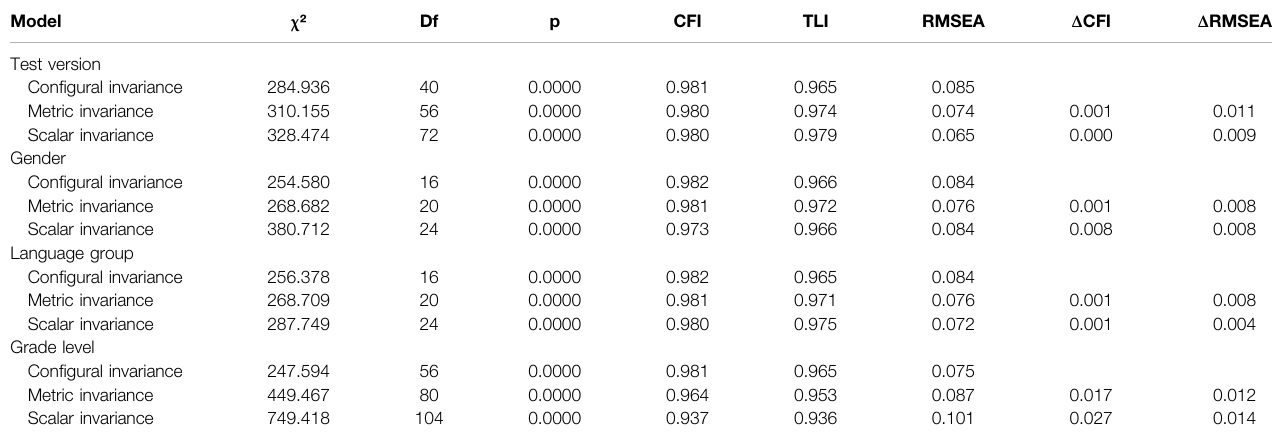
TABLE 3 | Summary of goodness of fi t for all models used in establishing measurement invariance across test version, gender, language group, and grade level for the dyscalculia screener (FUNA-DB).